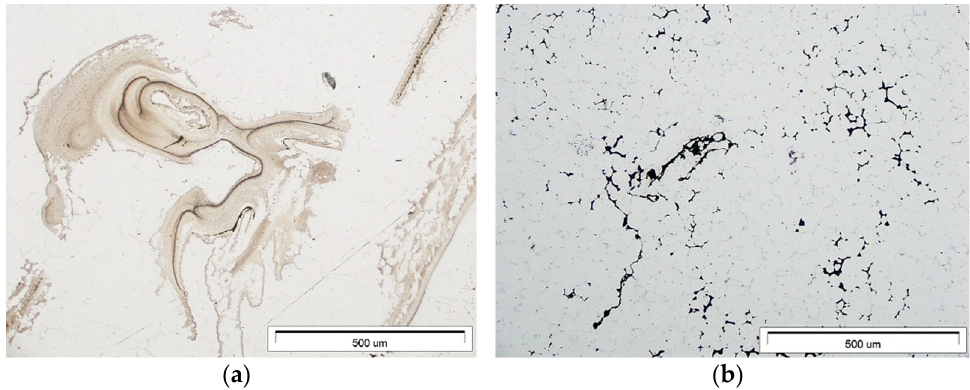
Figure 6. Stage 1 ( a ) Porosity in feeding gates areas; ( b ) Corresponding X-ray image.